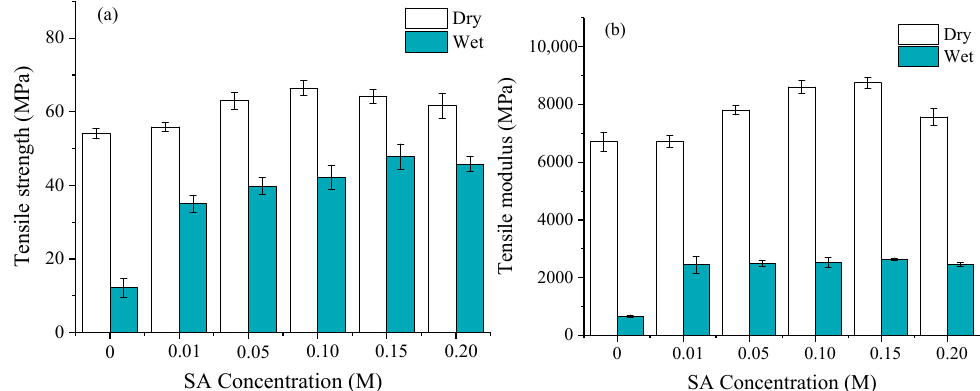
Figure 7. The effect of SA concentration on ( a ) tensile strength and ( b ) tensile modulus of modified NP in dry and wet conditions.